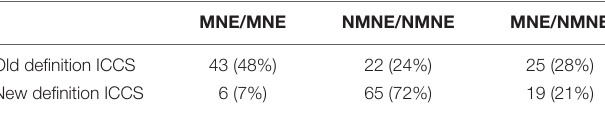
TABLE 3 | Diagnosis groups based on the old and new ICCS definitions for NMNE. The prevalence of MNE is significantly lower when the new definition is